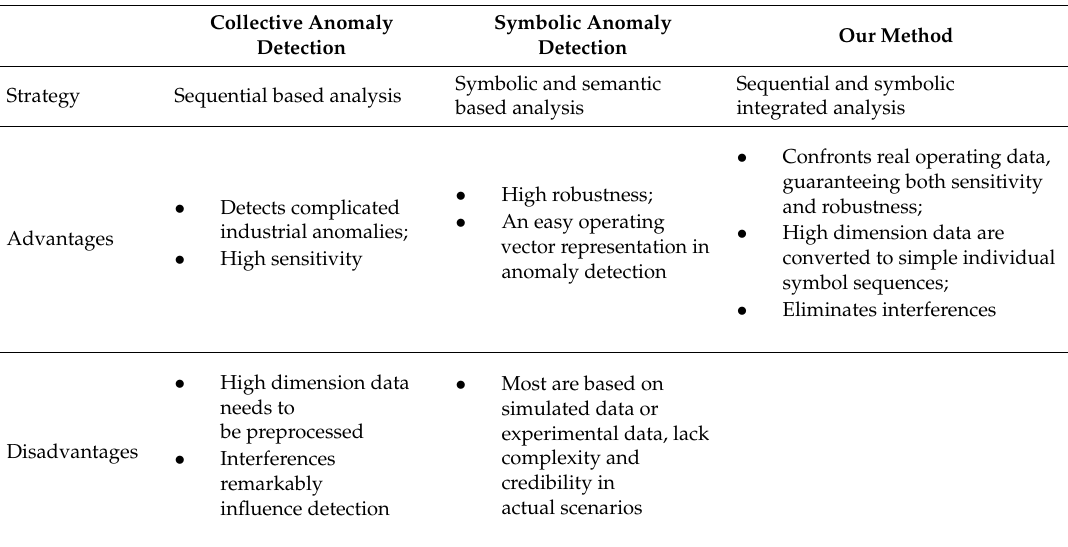
Table 1. Comparison between different current methods and ours.